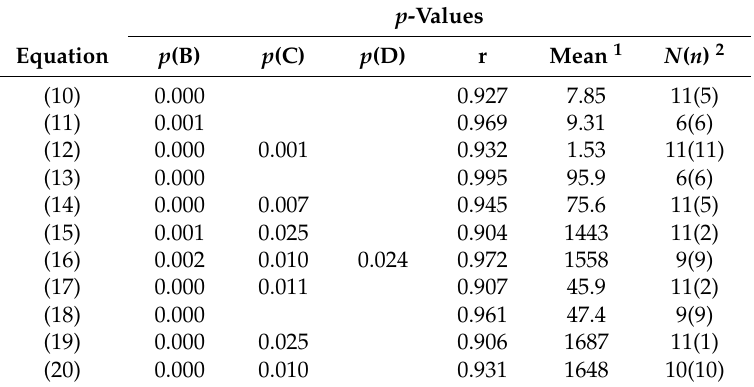
Table 4. Statistics of linear equations for the prediction of aqua-regia-extractable contents of trace metals (X(pred)) from the readings (soil and mining methods) obtained using pXRF on the sewage sludge